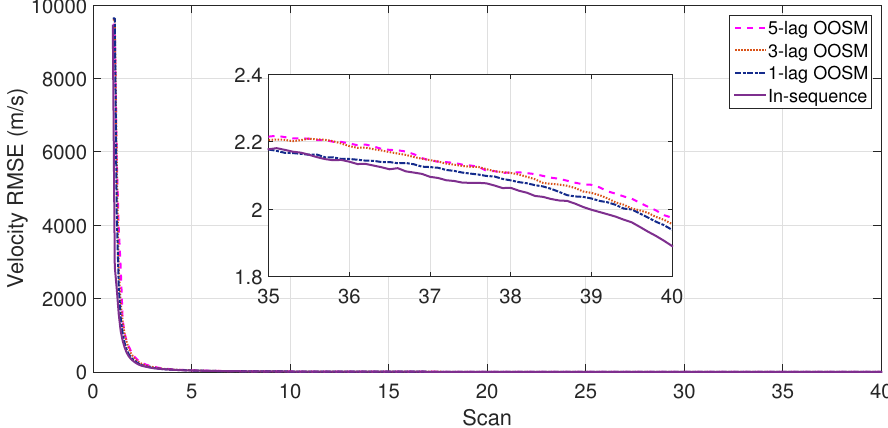
Figure 5. Root mean square error (RMSE) in position estimate for the A l 1 algorithm.